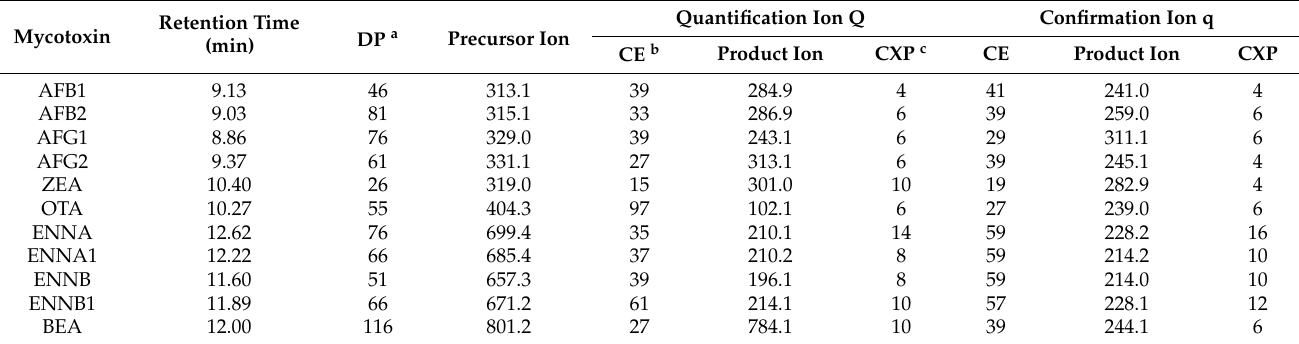
Table 1. Spectrometric parameters of liquid chromatography ion trap tandem mass spectrometry (LC-MS/MS-IT). Retention Time Mycotoxin